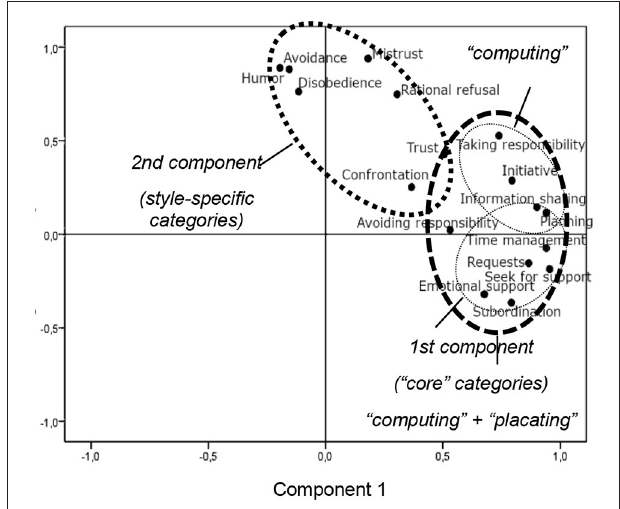
FIGURE 1 | Identification of significant categories using the method of principal